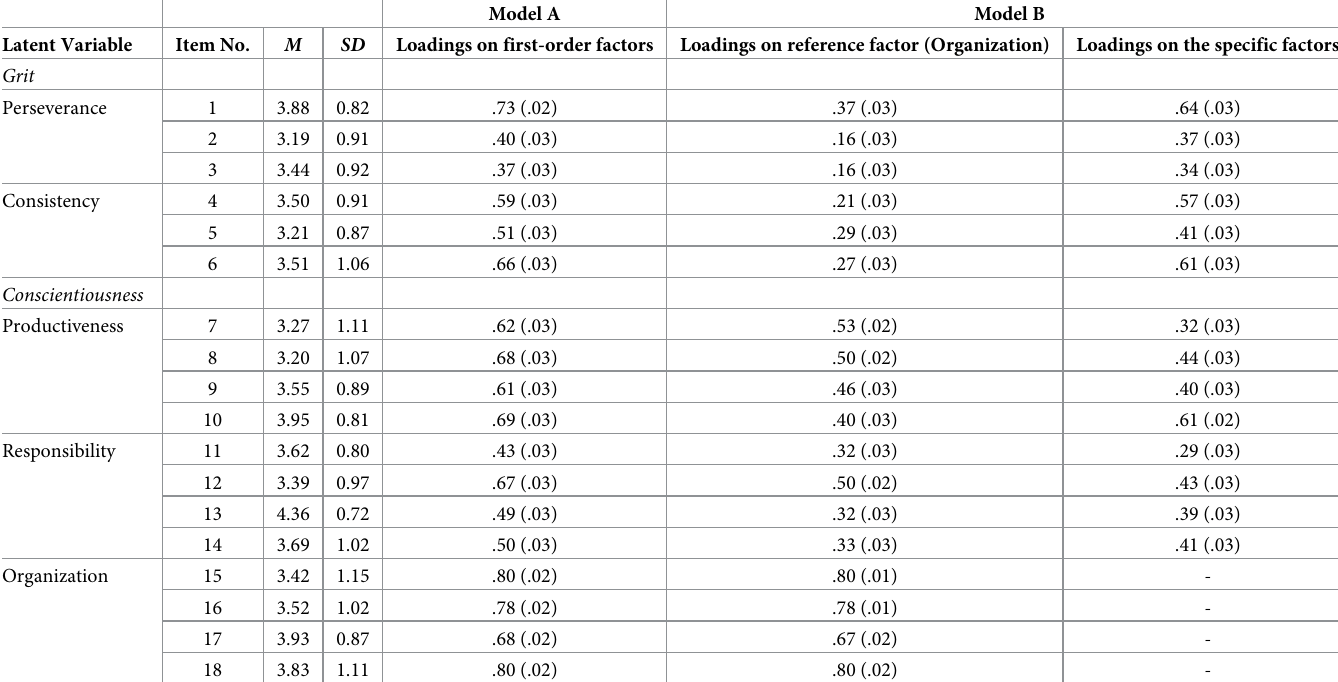
Table 2. Descriptive statistics and standardized factor loadings for Model A and Model B (standard errors are given in